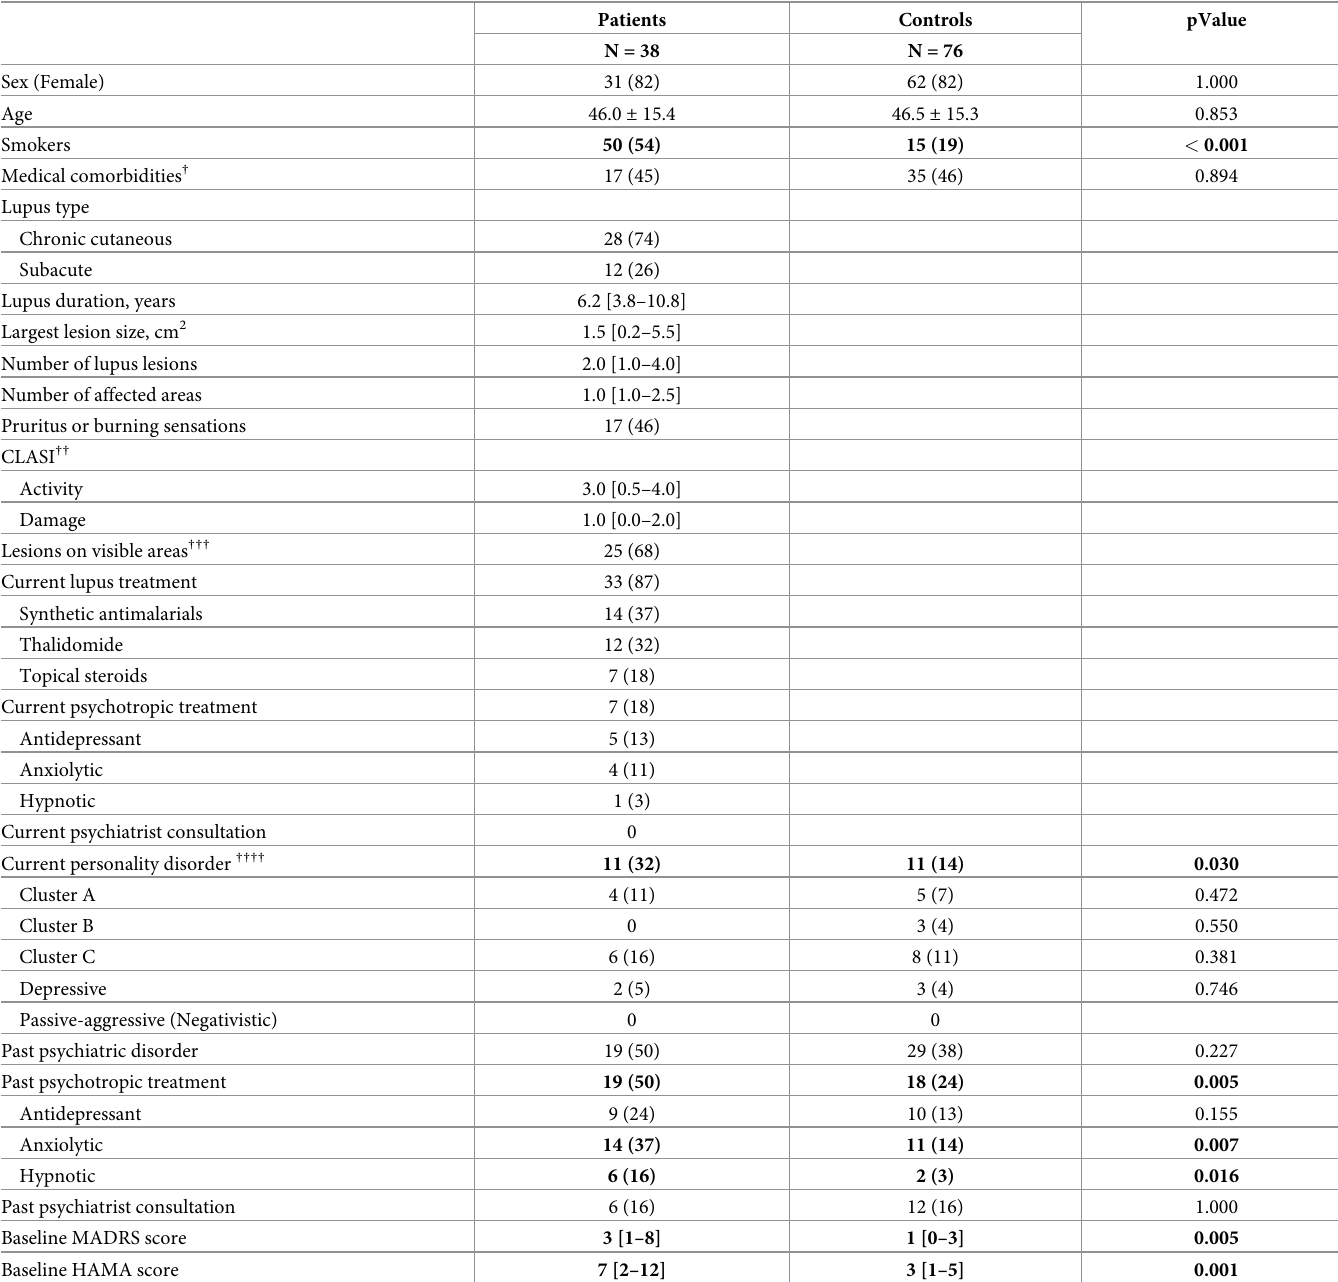
Table 1. Participant